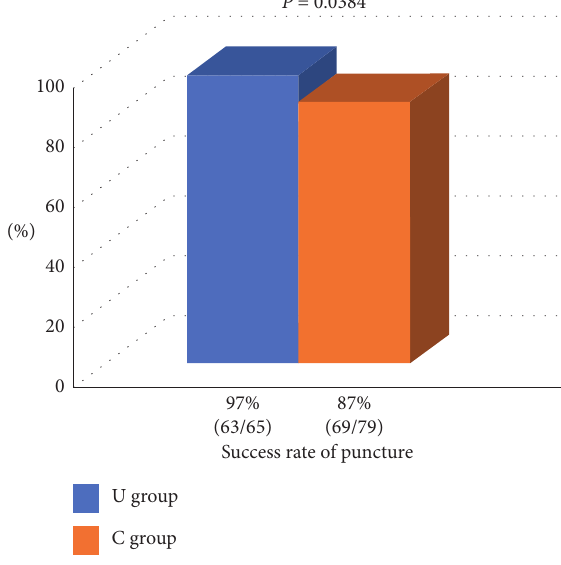
Figure 3: The success rate of